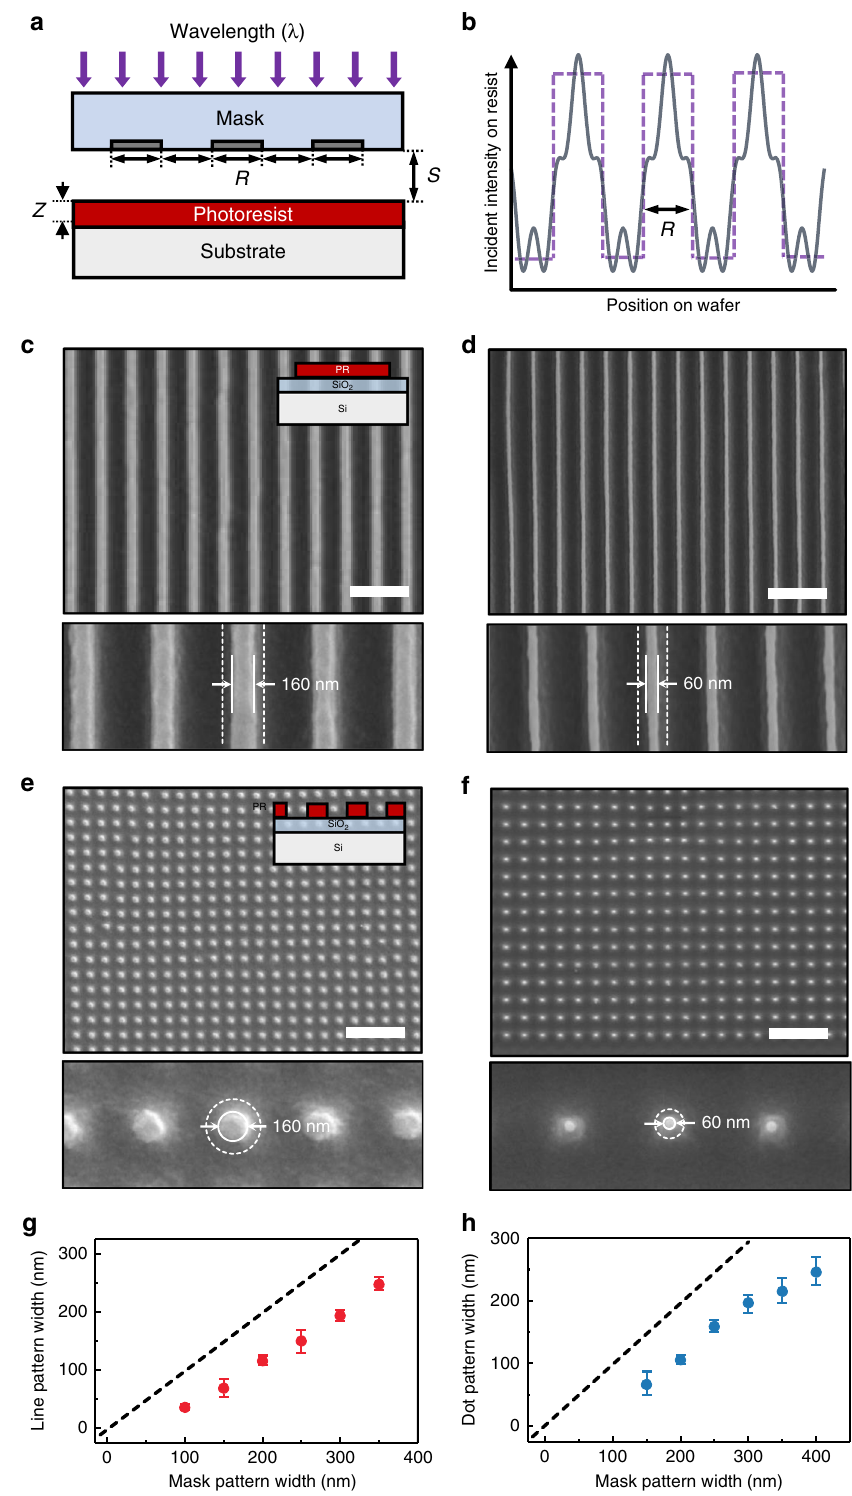
Fig. 3 Cr pattern in soft mask can be transferred to photoresist features with great size control. a Schematic illustration of shadow printing mode optical lithography. R , S, and Z are the width of pattern, the gap between mask and photoresist surface and the thickness of photoresist, respectively. b Light- intensity distribution at the surface patterned by contact printing with gap ( S > 0, solid gray line) and without gap ( S = 0, dotted purple line). c , d SEM images of photoresist line features de fi ned by Cr patterns of 300 nm ( c ) and 150 nm ( d ) in width. Dotted lines indicate the size of the chrome pattern in soft mask. Scale bar: 1 μ m. e , f SEM image of photoresist dot features de fi ned by Cr patterns of 300 nm ( e ) and 150 nm ( f ) in diameter. Dotted circles indicate the size of the chrome pattern in soft mask. Scale bar: 2 μ m. g Photoresist line feature variation (red dots) depending on Cr pattern width. h Photoresist dot feature variation (blue dots) depending on Cr pattern diameter. In ( g , h ), error bars indicate a maximum and minimum value in the experiment results and the dotted line is guiding line ( y = x